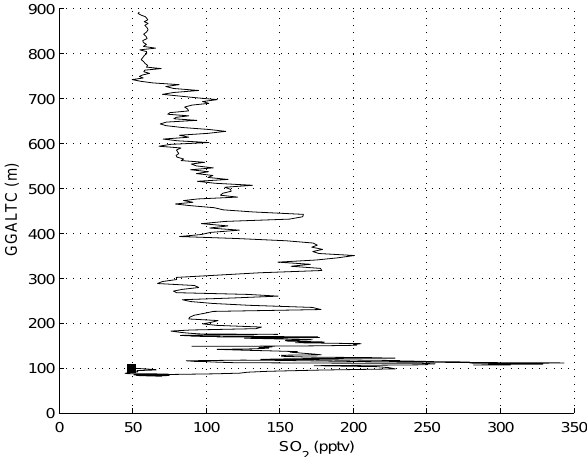
Fig. 2. Portion of the C-130 descent in clear air to the start of the first surface circle (filled square). SO 2 > 100pptv from probable ship plumes was mixed to 500ma.s.l. Data obtained at 25sampless − 1 were integrated to 1s − 1